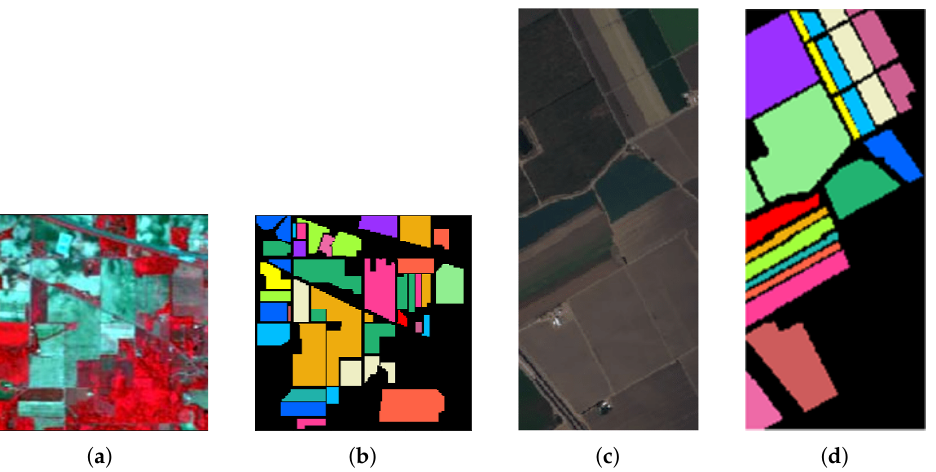
Figure 8. ( a ) The false color image of the Indian Pines dataset [57], ( b ) The corresponding ground- truth map. ( c ) The false color image of the Salinas dataset [22], ( d ) The corresponding ground- truth map.